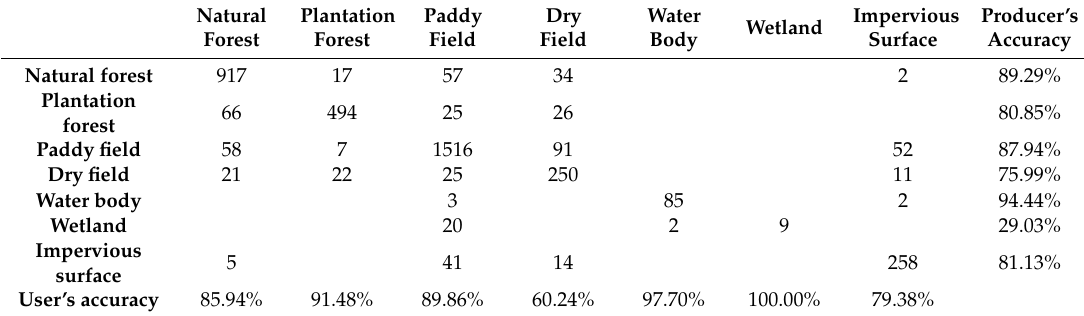
Table 3. Confusion matrix for SBT classification.